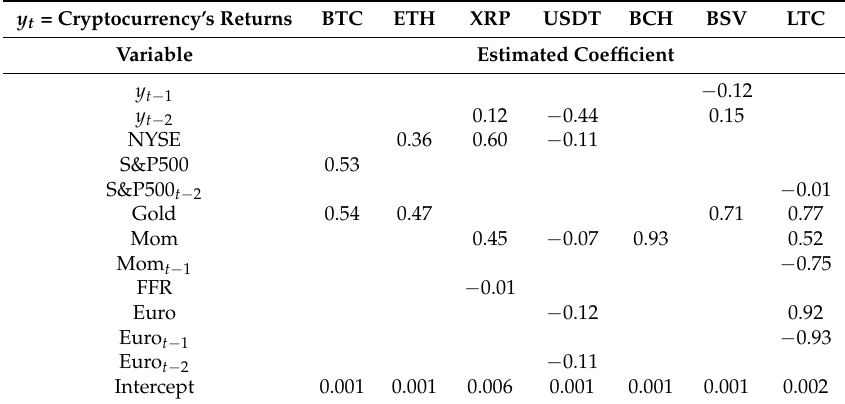
Table 7. Cryptocurrency returns